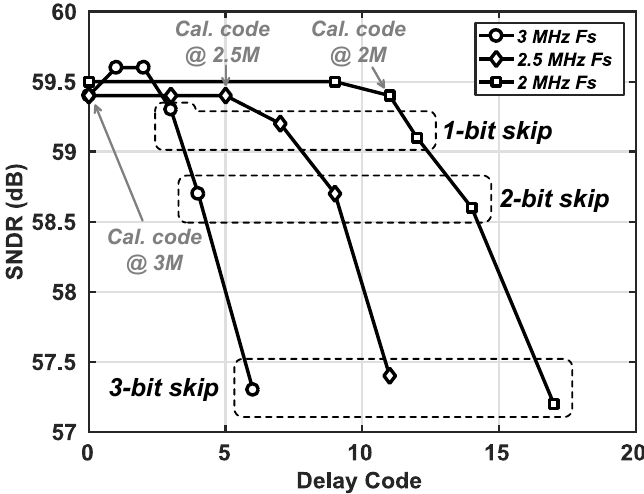
Figure 11. SNDR performance of SAR ADC as delay codes.